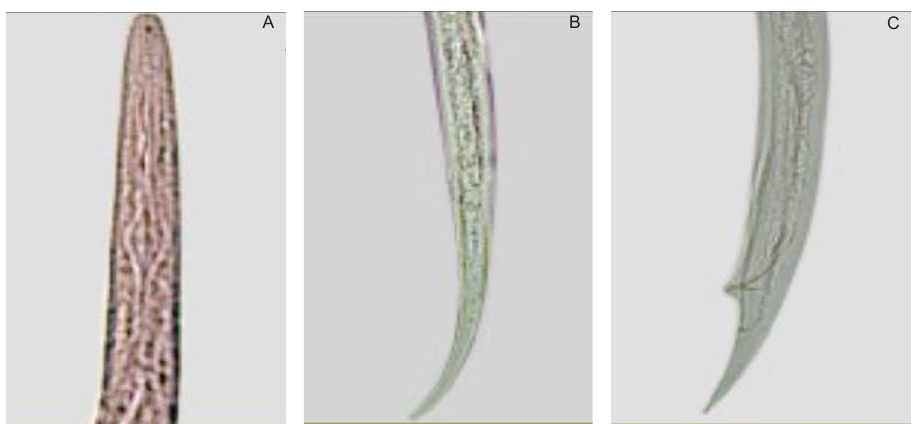
Image I. Zanenchus zanchus Siddiqi, 1979. A - Anterior end; B - Posterior end; C - Male - Posterior end